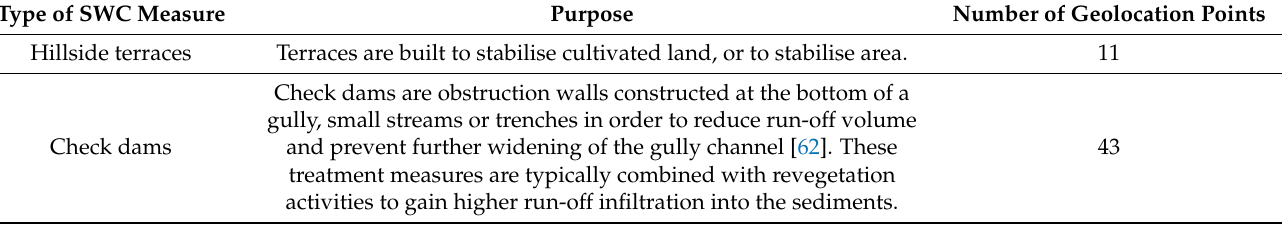
Table A1. Description of soil and water conservation (SWC) measure data.